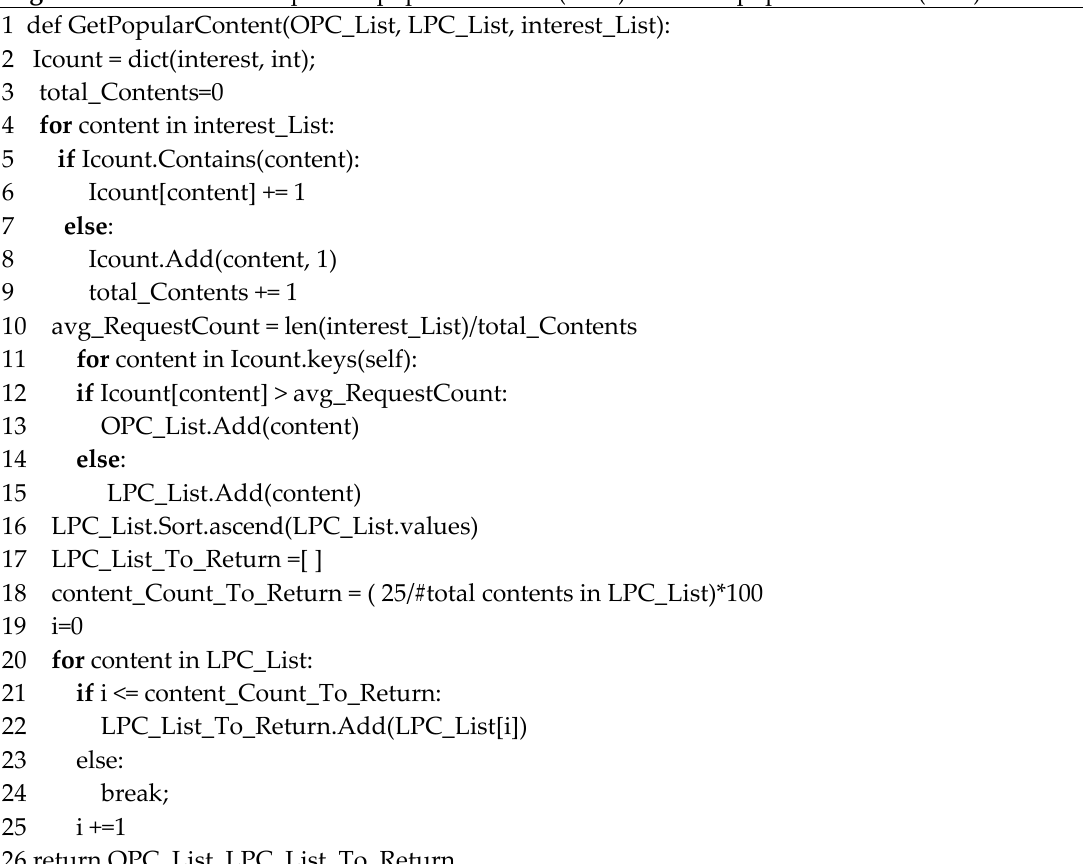
Algorithm 1 Selection of optimatl popular content (OPC) and least popular content (LPC)